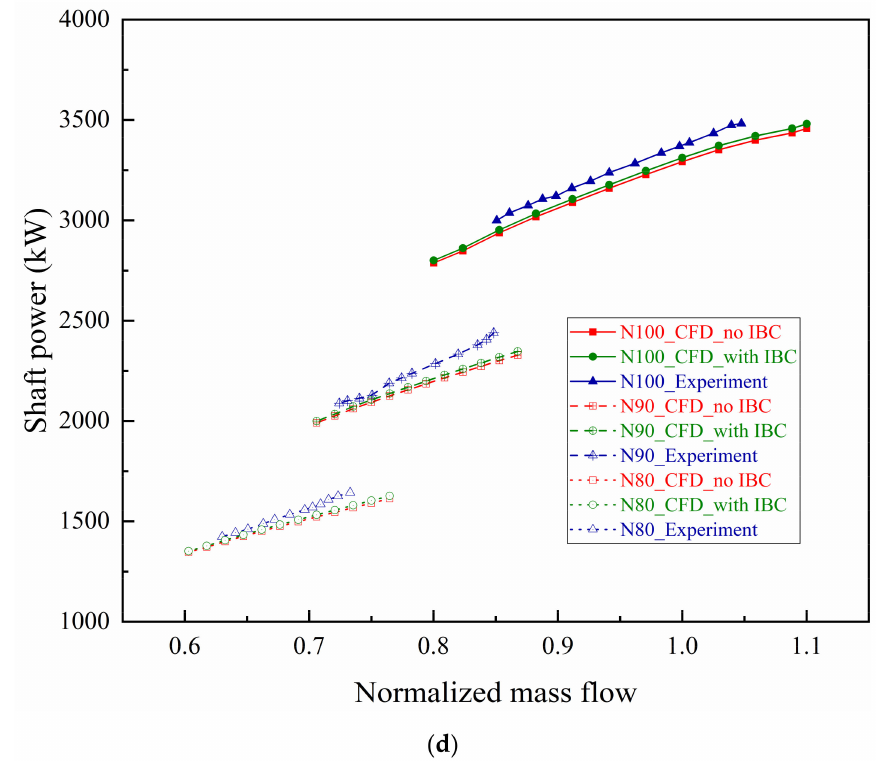
Figure 10. Predicted and measured aerodynamic performance parameters under variable rotating speeds: ( a ) total pressure ratio; ( b ) isentropic efficiency; ( c ) torque; ( d ) shaft power.